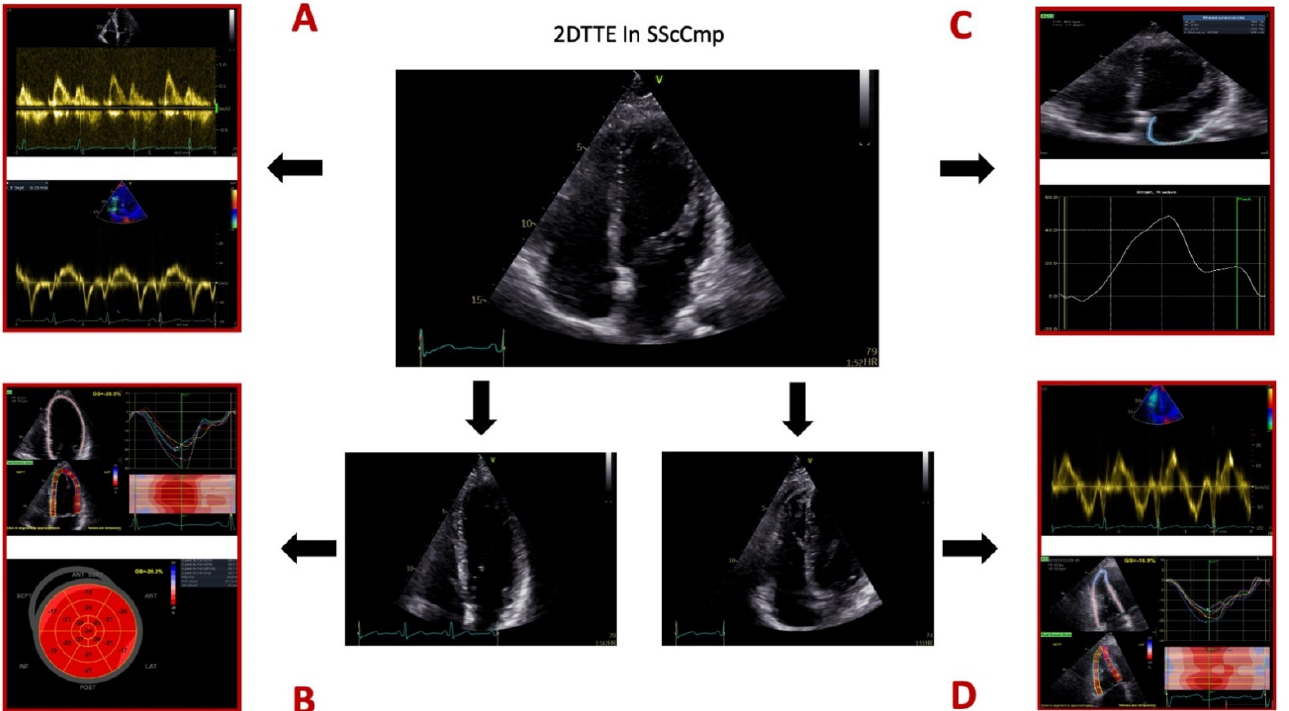
Figure 1. Different 2D transthoracic echocardiographic techniques used for evaluating the patients with systemic sclerosis and primary myocardial disease. Legend: Panel ( A ), mitral valve inflow profile by pulsed-wave (PW) Doppler, Tissue Doppler Imaging (TDI) for myocardial velocities. Panel ( B ), speckle-tracking echocardiography (STE) for assessing global longitudinal strain of the left ventricle (LV GLS). Panel ( C ), STE for assessing left atrial (LA) longitudinal strain. Panel ( D ), right ventricular (RV) evaluation comprised of TDI evaluation of RV free wall systolic velocity and RV free wall longitudinal strain. Images from the personal collection of the authors.